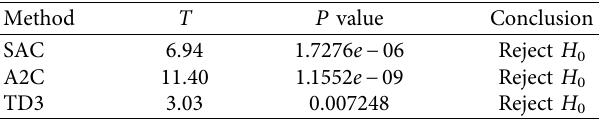
Table 4: Student’s t -test results for comparing PPO2 with other RL algorithms.